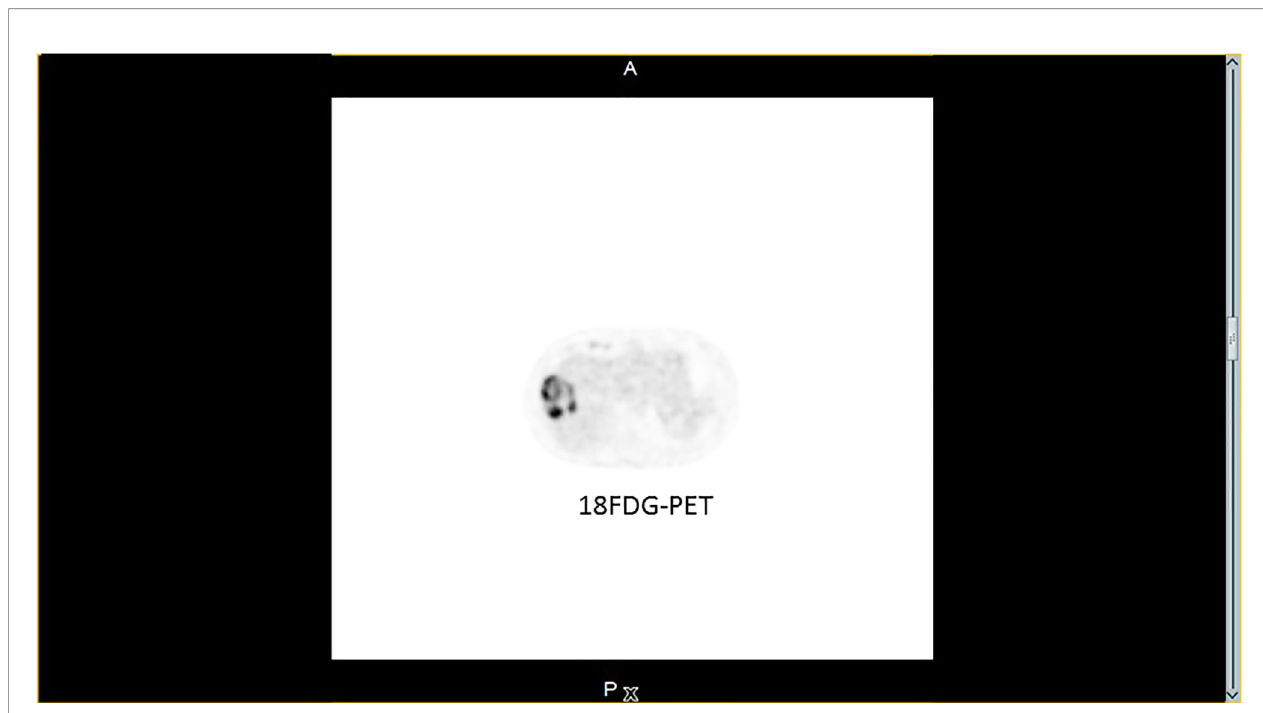
FIGURE 2 | 18 FDG-PET. 18 FDG-PET image from March 2016: major uptake in the progressing lesion; no other suspect foci was